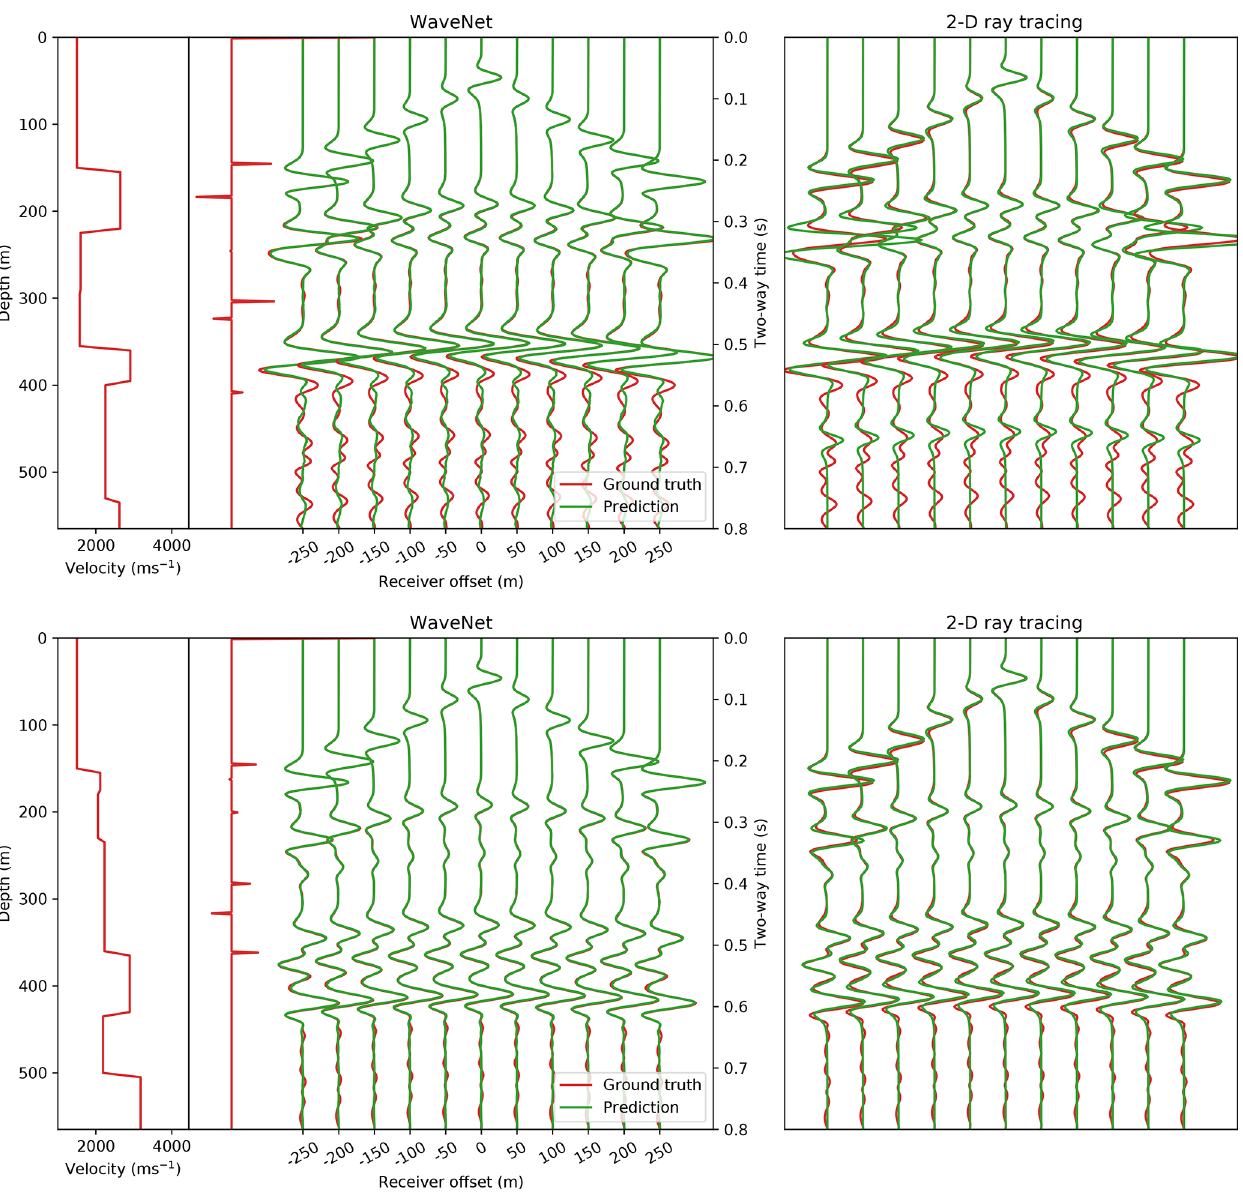
Figure 5. Comparison of WaveNet simulation to 2-D ray tracing. We compare the WaveNet simulation to 2-D ray tracing for two of the examples in Fig. 4. Red shows the input velocity model, its corresponding reflectivity series and the ground truth pressure responses from FD simulation. Green shows the WaveNet simulation (left) and 2-D ray tracing simulation (right). A t 2 . 5 gain is applied to the receiver responses for